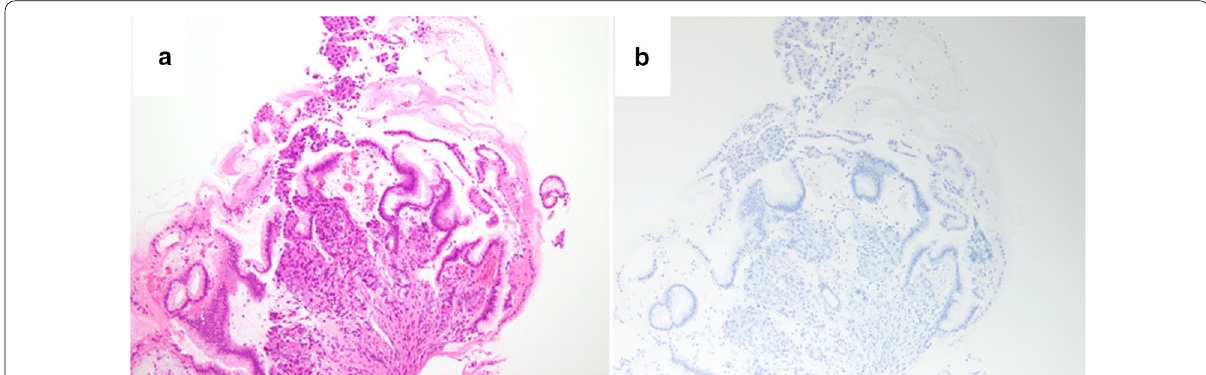
and b original magnification